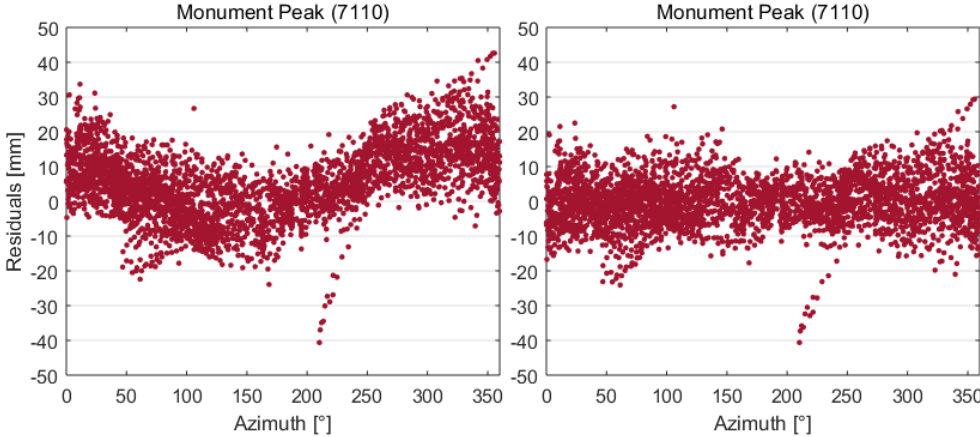
Figure 4. Residual dependency on Monument Peak station azimuth angles for solutions with uncorrected ( left ) and corrected ( right ) range